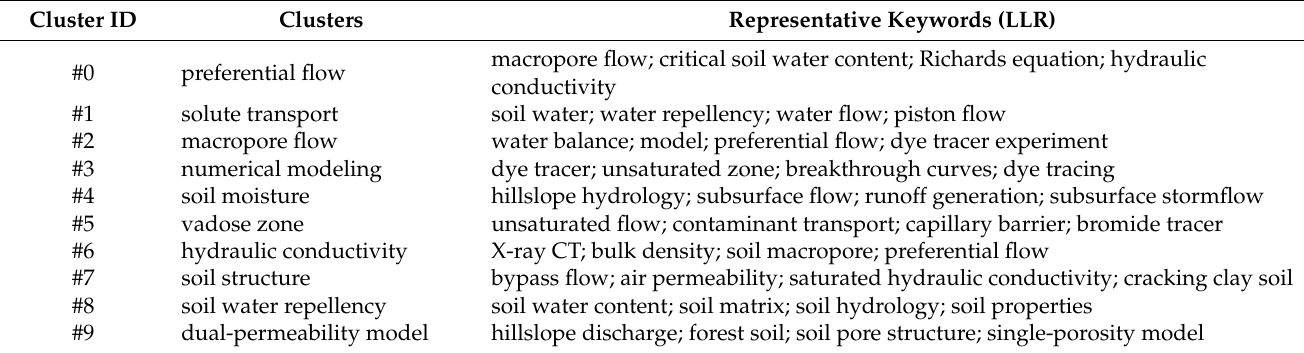
Table 3. Preferential flow clustering and representative keywords from WoS